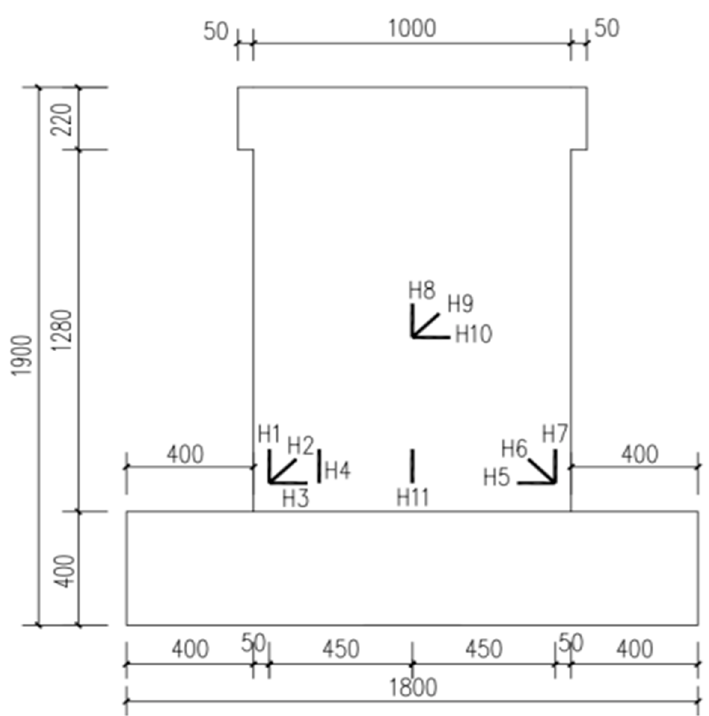
Figure 6. Concrete strain gauge layout. Notes: The unit of length is mm.